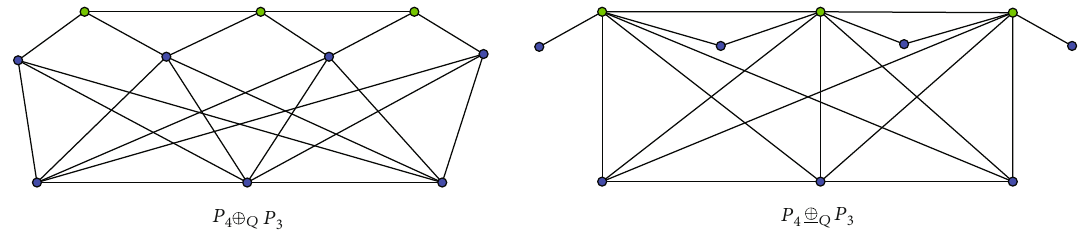
Figure 4: The VQG and EQG of P